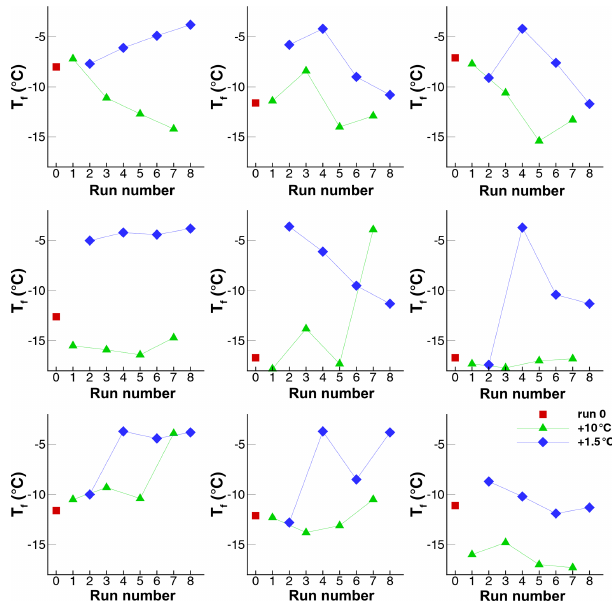
Figure 17. Sequences of freezing temperatures for drop numbers 44, 48, 53, 55, 58, 65, 66, 69, and 81 in Exp.